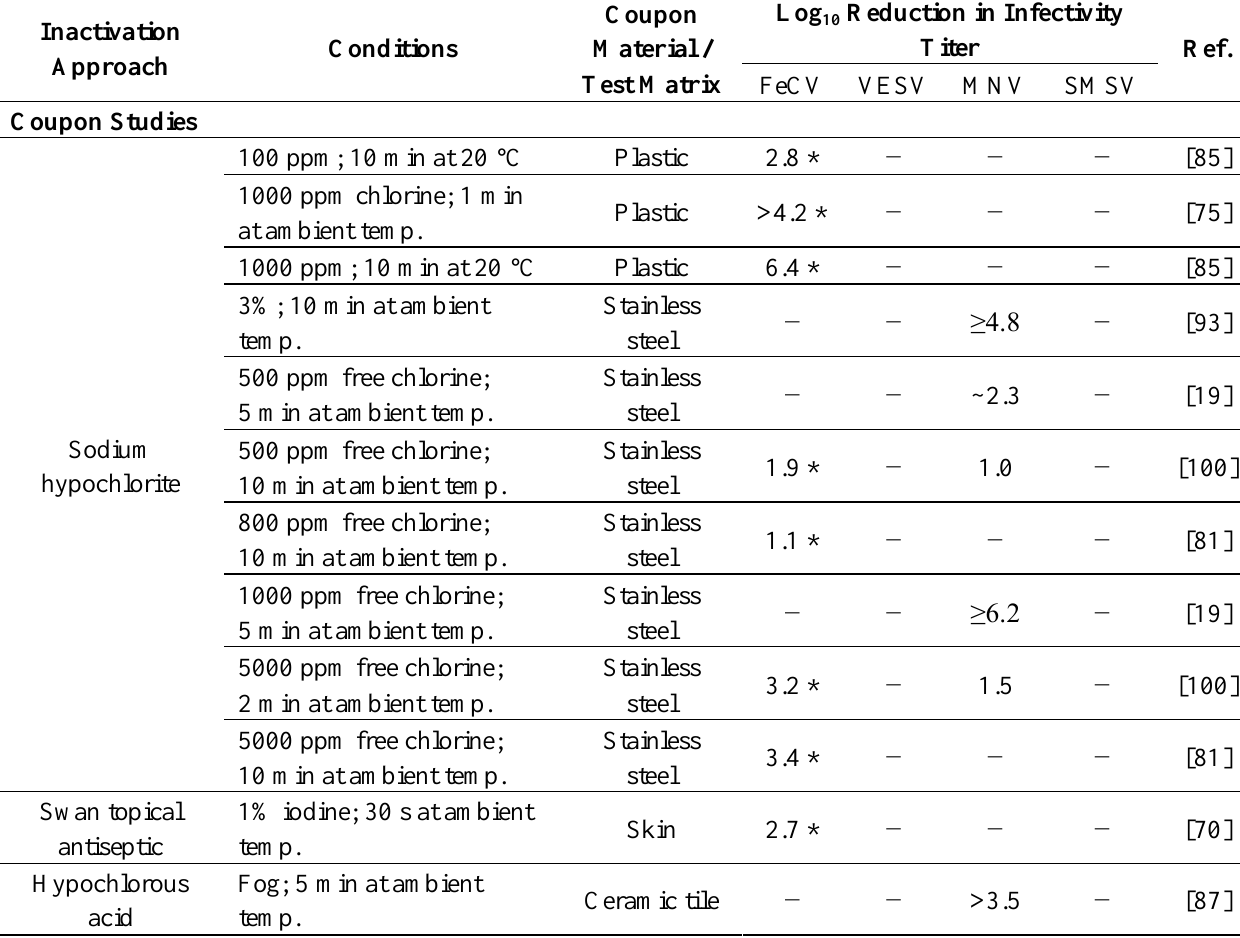
Table 7. Inactivation of caliciviruses by oxidizing